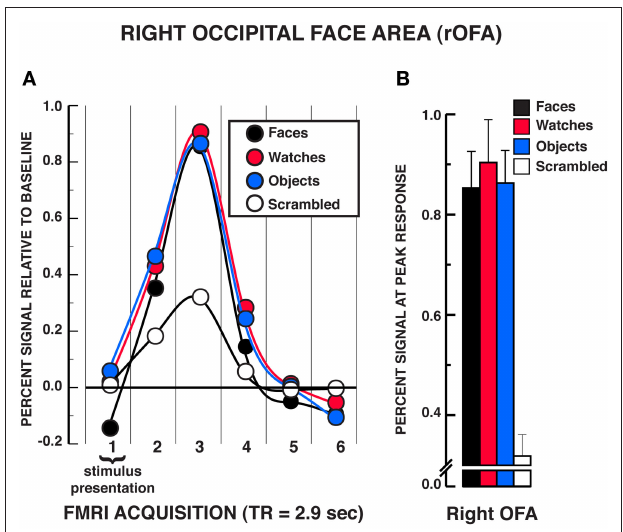
FIguRe 3 | FMRI BOLD results from the individuation task in the FFA regions of interest. (A) Estimated hemodynamic response function (HRF) for the faces, watches, diverse objects, and scrambled stimuli (mean from three individuation task runs) in the FFA. BOLD signal expressed in percent signal difference from null trial fixation baseline. The six acquisition volumes from the initiation of stimulus presentation were modeled. Each volume was acquired over 2.9 s (TR) that translates to the first volume acquired from 0 to 2.9 s, the second volume from 2.9 to 5.8 s, etc., and the entire HRF covered the 0–17.4 s